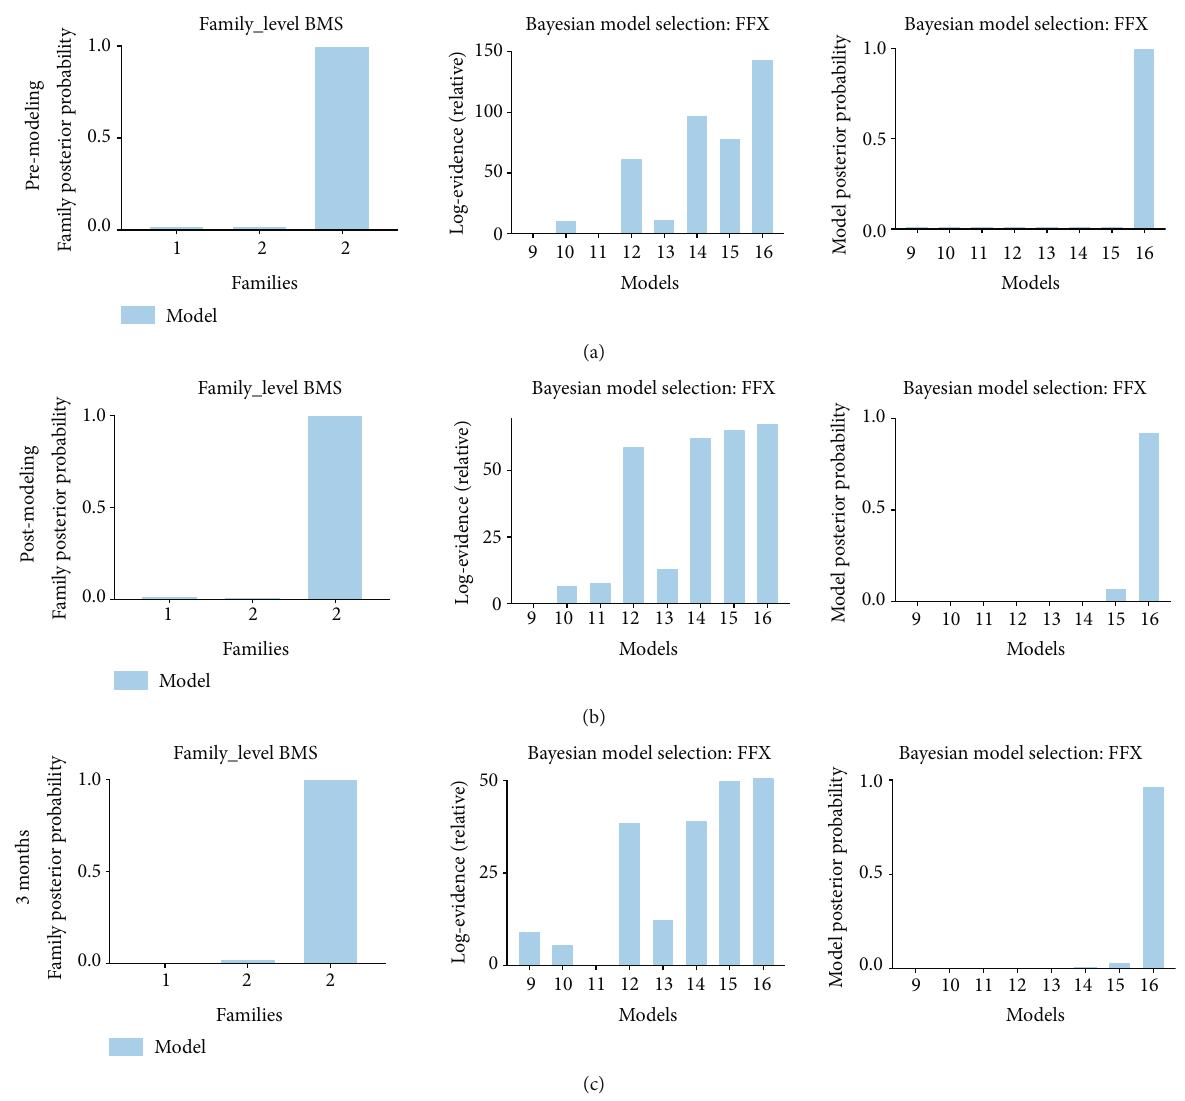
Figure 5: Results of Bayesian model selection for the model group. Results of BMS for the model group at premodeling (a), postmodeling (b), and after 3 months of treatment (c). The fi rst column examined which interregional connections are most likely to mediate pain propagation; the second column showed the corresponding Bayes factor, in line with the results of model-level inference; and the third column displayed the results of model-level